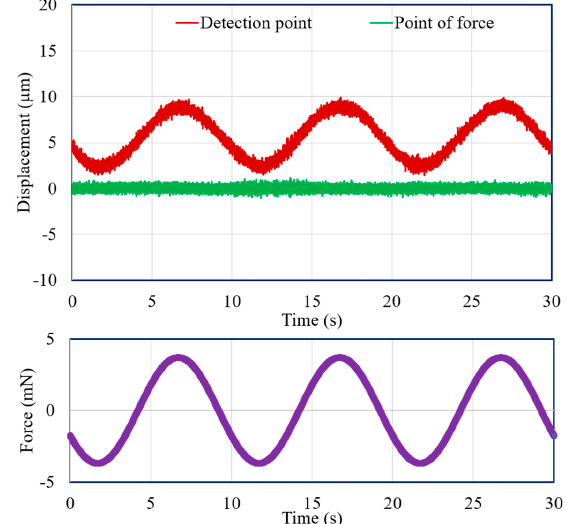
Figure 13. Displacements of the point of force and detection point with a dynamic force of 3.7 mN and a 0.1-Hz frequency.